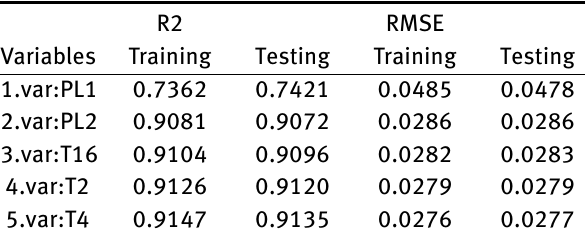
Table 1: Selected variables and modelling result for booster pump